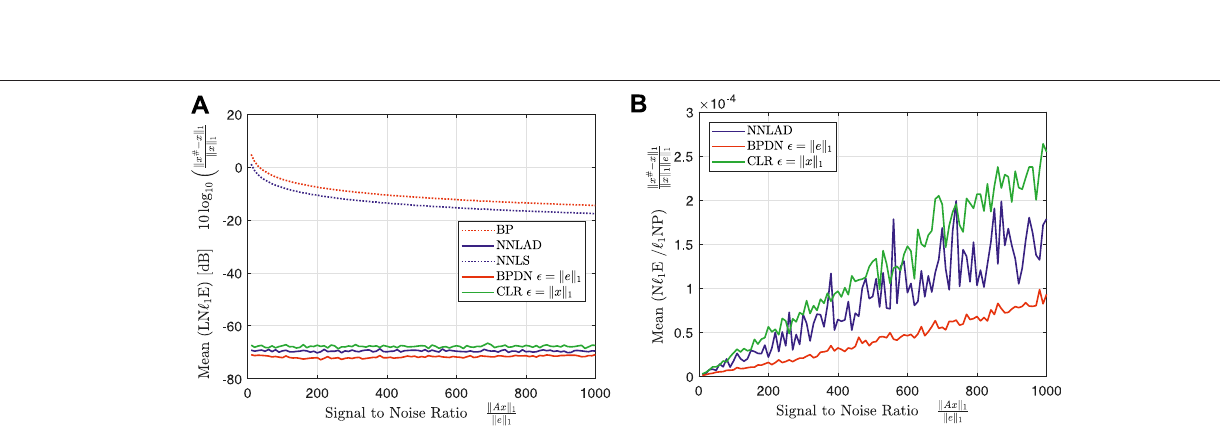
FIGURE4| PerformanceofNNLADfor noisewithpeaky massand varyingnoisepower. (A) The NNLADoutperforms theNNLS. (B) Theestimationerror does not scale linearly with the noise power.